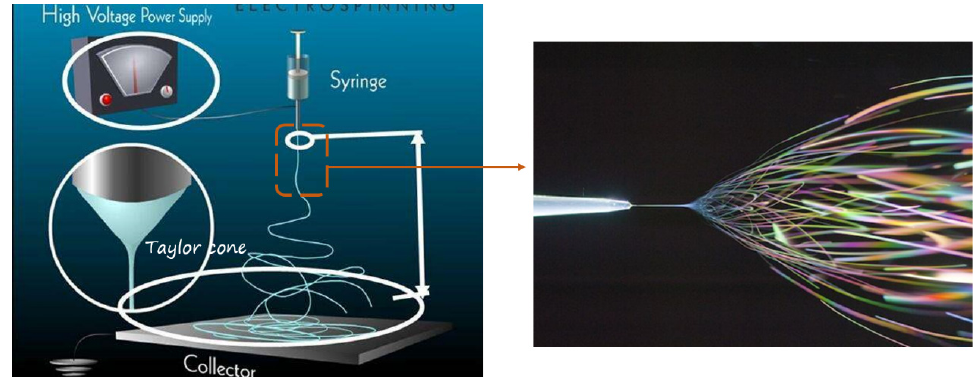
Fig. 1. Schematic of solution electrospinning